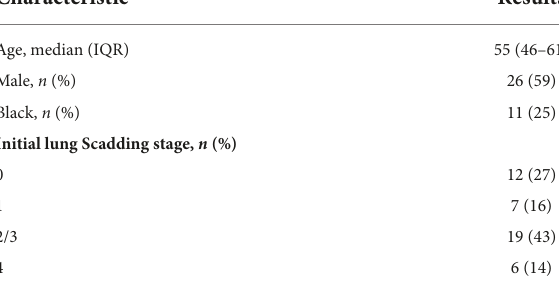
TABLE 1 Demographic and clinical characteristics of patients with cardiac sarcoidosis ( N =